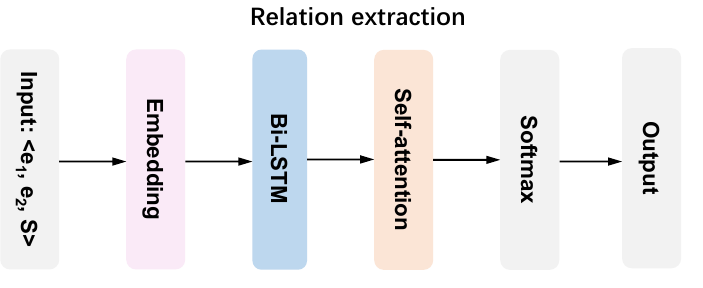
Figure 7. Relation